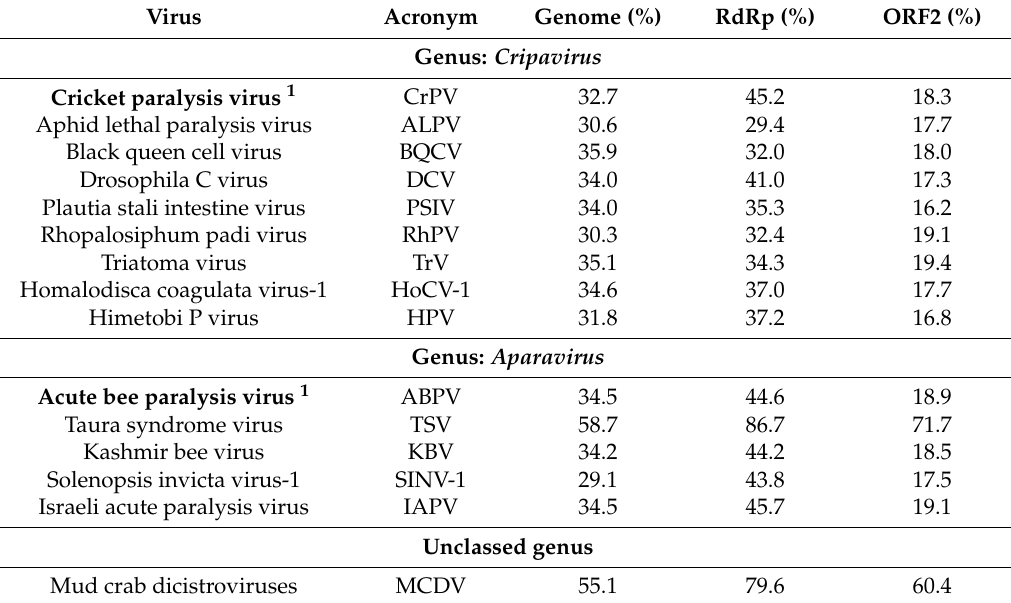
Table 1. Sequence similarity of the full-length genome, deduced RdRp, or structural protein of the MrTV to other dicistrovirues. The reference sequences of dicistrovirues were indicated in Figure 4. Virus